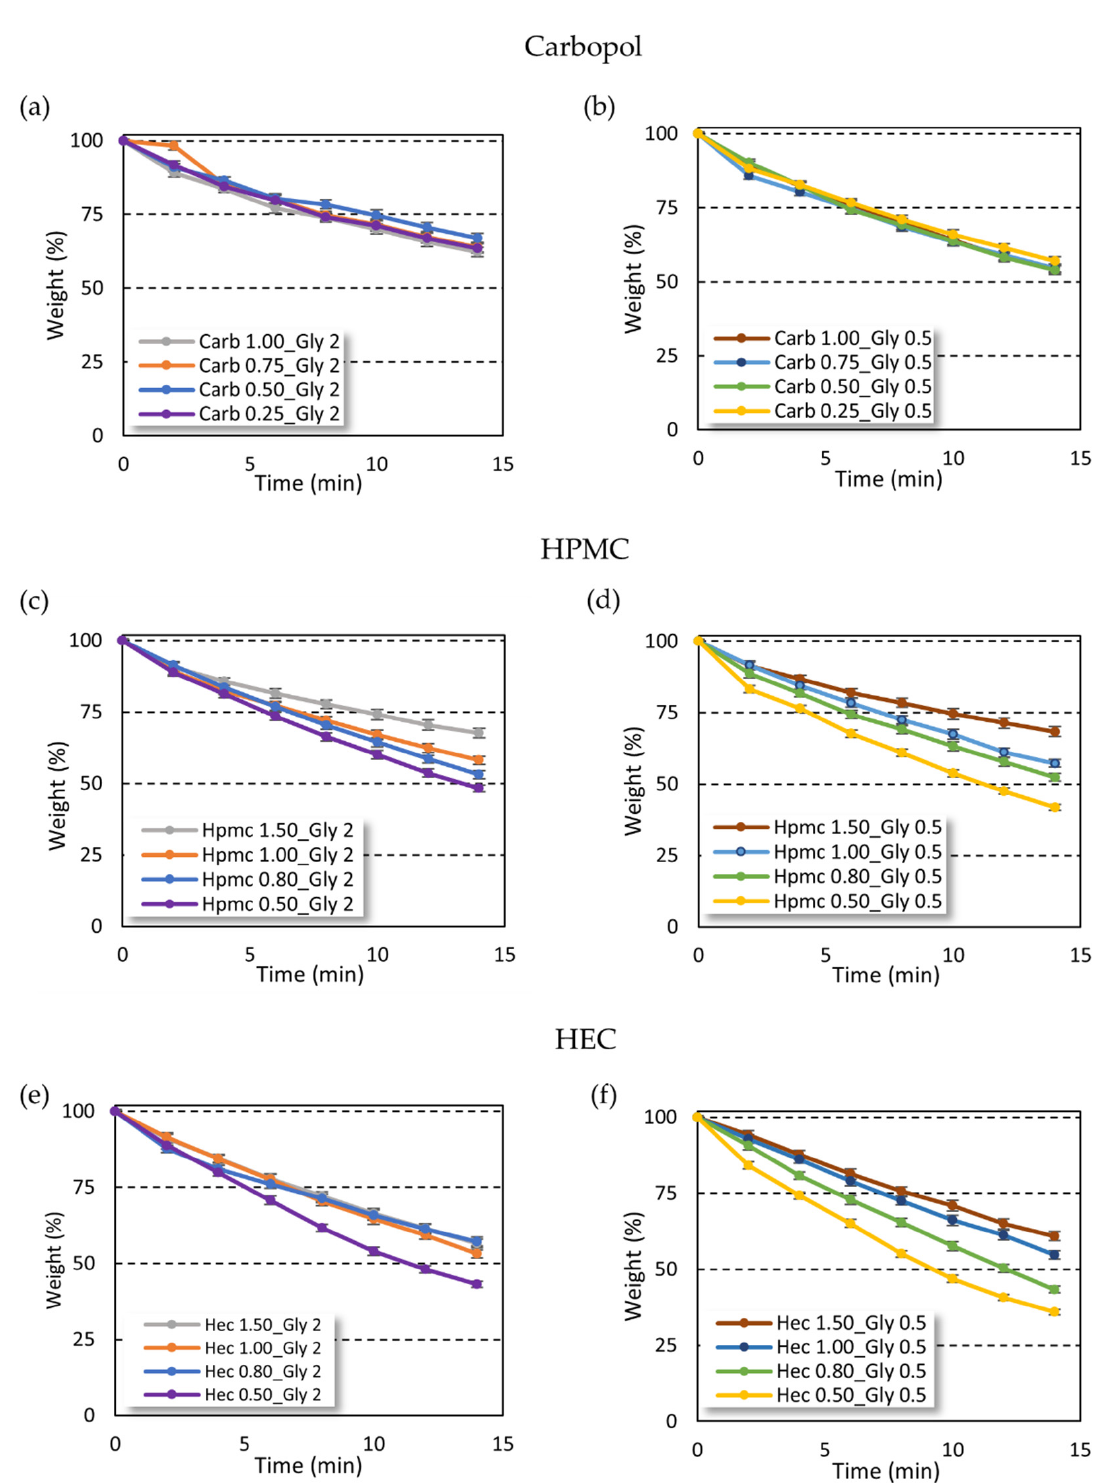
Figure 4. The hydro-alcoholic solvent evaporation rate from gels. The results are reported as weight of gel percentage in the time. ( a , b ) Carbopol-based gels; ( c , d ) HPMC-based gels; ( e , f ) HEC-based gels.